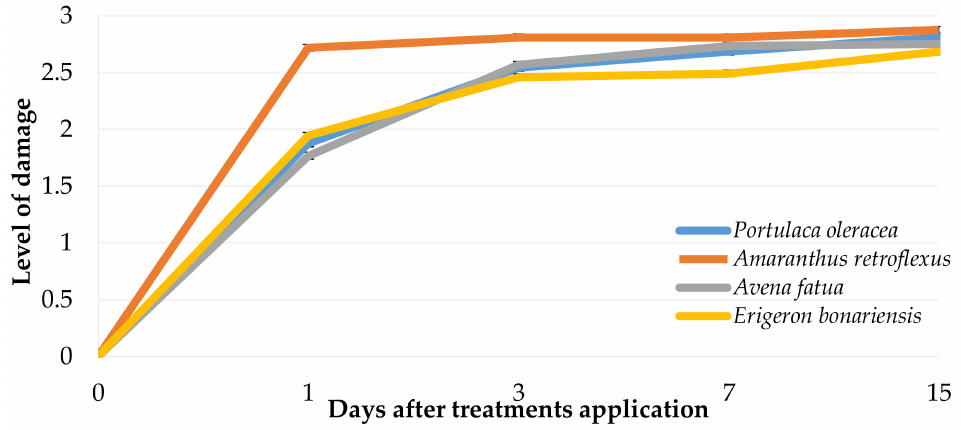
Figure 9. E ff ect of treatment and time after treatment interaction on damage